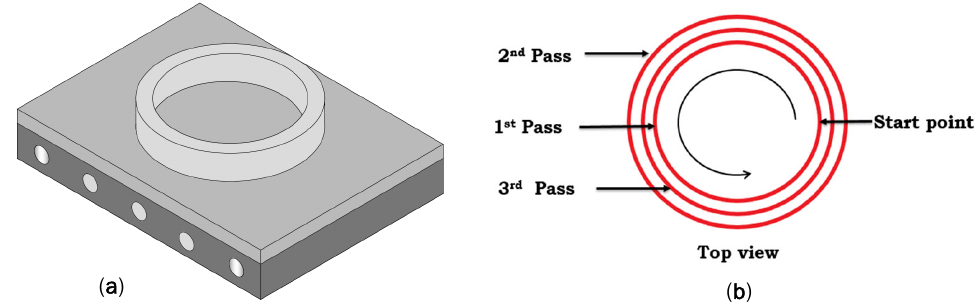
Figure 2. ( a ) Representative 3D view; ( b ) Pattern of deposition. Table 2. EN8 alloy weld plate, coolant plate and fi ller wire properties.